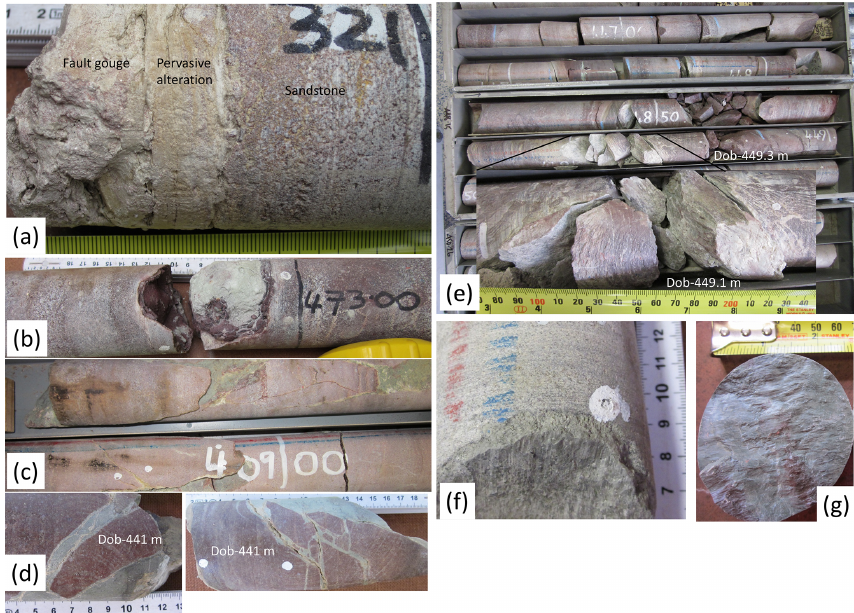
Figure 2. Photos of sampled cores showing fault gouges investigated in this study. Foliated and veined clay-rich fault gouges with light grey– green colour distinctive from adjacent brown hematite-rich sandstone host rock (a–e) . Fault gouge veins are characterized by an ultra-fine- to fine-grained matrix and angular to subangular fragments of host sandstone of various sizes, ranging from submicrons to centimetres (b) . Ultra-cataclastic veins are common, which are observed as simple veins, complex lenses, and networks (c–d) . Foliated fault gouge zone with alternating red hematite-rich and grey–green layers (e) . Slickenside structure is a commonly seen at the sharp contact between the clay-rich fault gouge layers and the host rock (f–g)